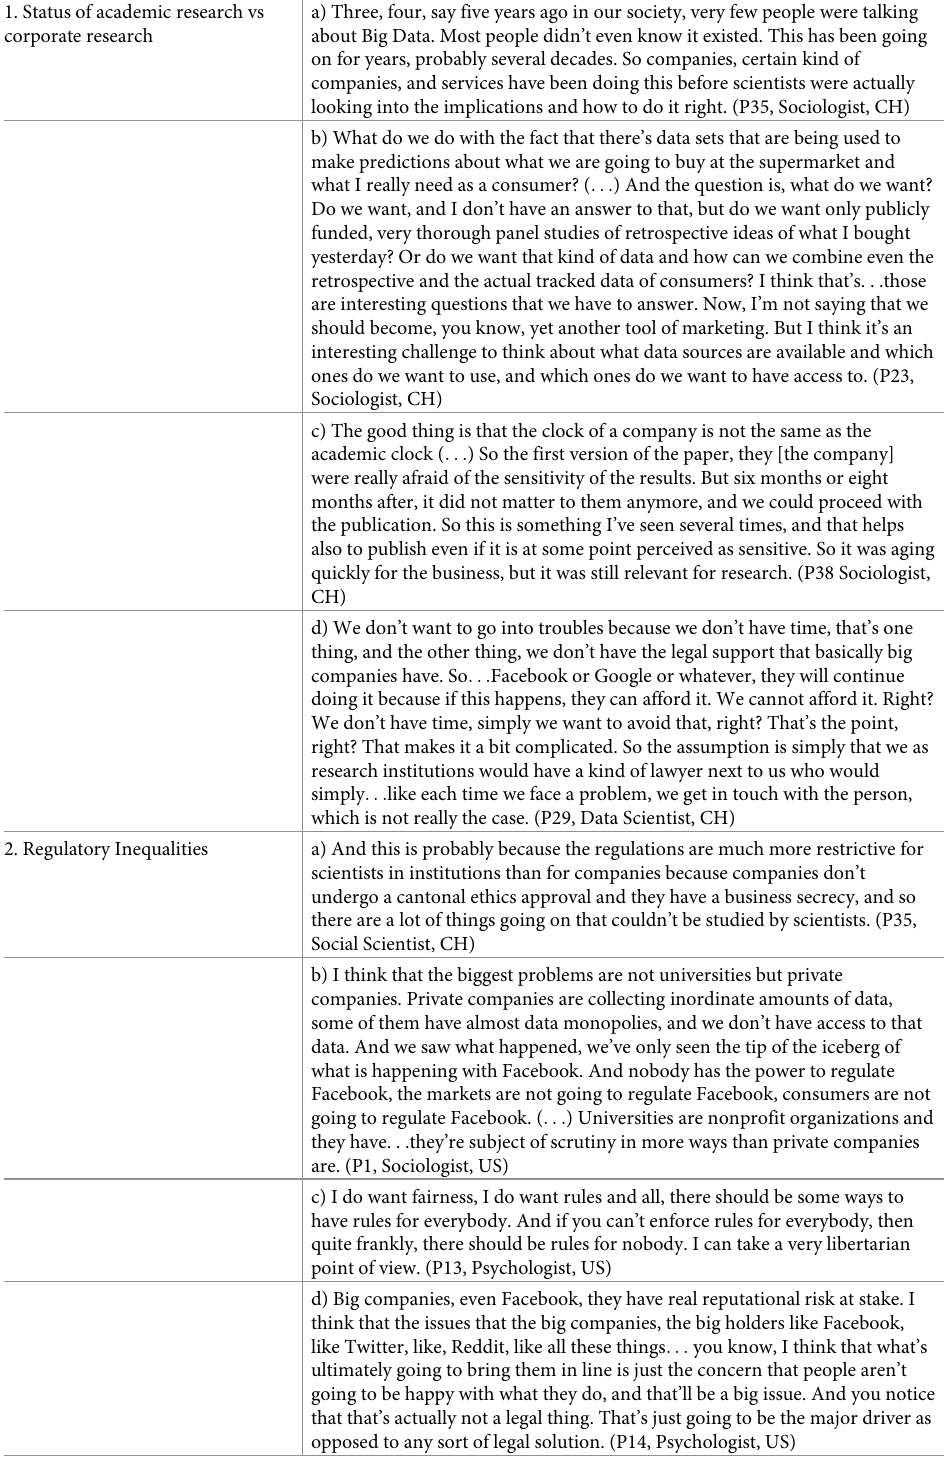
Table 8. Relevant quotes over differences between corporate and academic